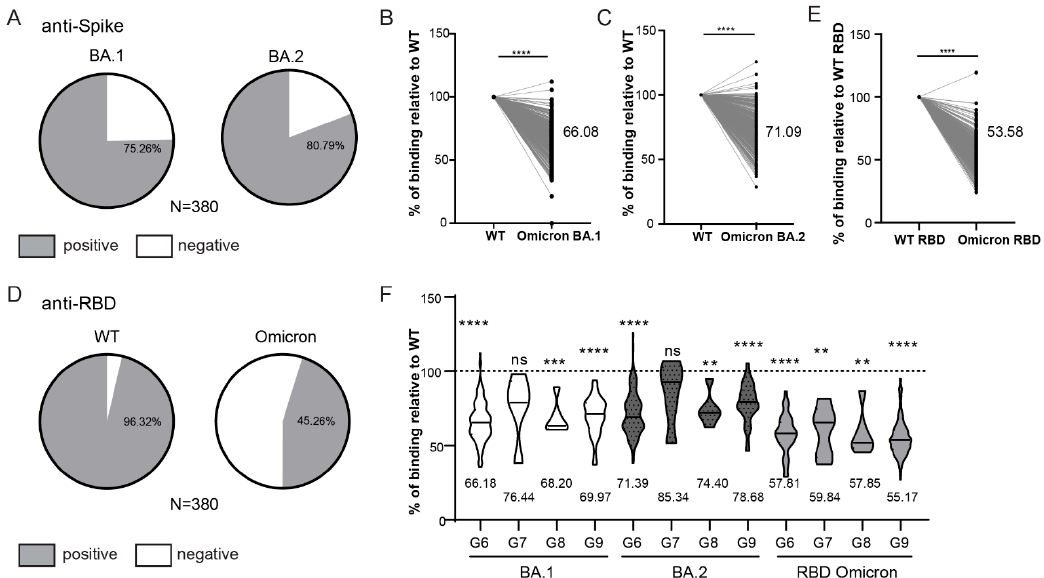
Figure 3. Reactivity of vaccinated HCW’s sera to Omicron Spike variants. ( A ) Rates of 6-month vaccinees (t2) samples reactive to Omicron BA.1 and BA.2 Spike protein. ( B ) Comparison of the intensity of t2 serum binding to Omicron BA.1 and ( C ) BA.2 relative to binding to WT Spike protein. ( D ) Rates of t2 samples reactive to WT RBD and Omicron RBD protein. ( E ) Comparison of the intensity of t2 serum binding to Omicron RBD protein relative to binding to WT RBD protein. ( F ) Compari-